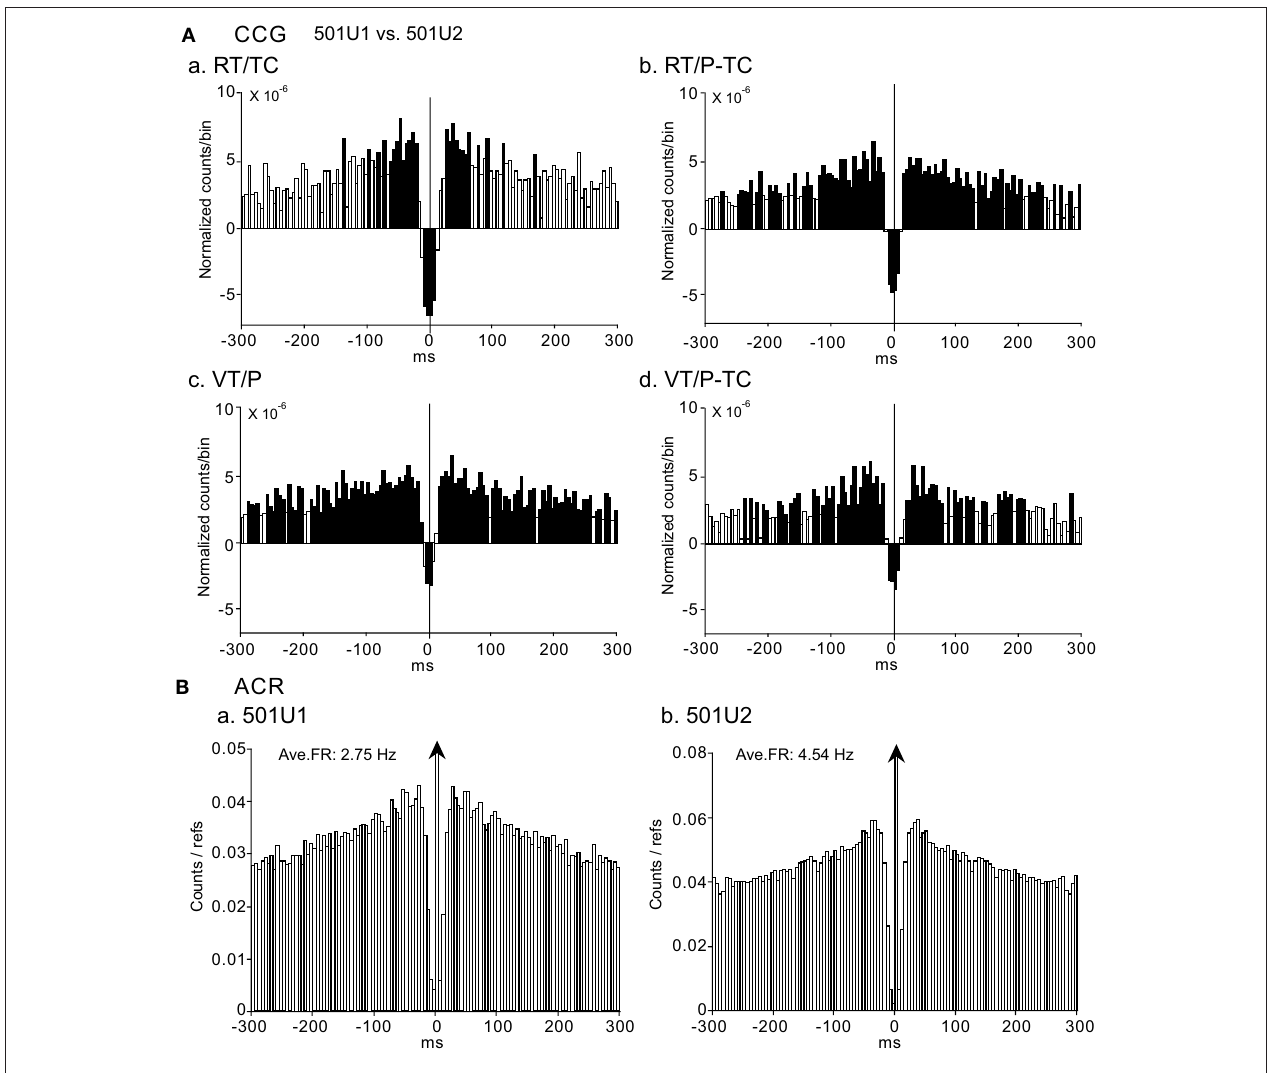
each task for neurons 501U1 and 501U2 were 1714 and 6623 spikes in the RT/ TC, 3763 and 5698 spikes in the RT/P-TC, 3027 and 6273 spikes in the VT/P, and 1062 and 2659 spikes in the VT/P-TC tasks, respectively. (B) ACRs of the same neurons in (A) [ (a) 501U1; (b) 501U2). Other descriptions as for Figure